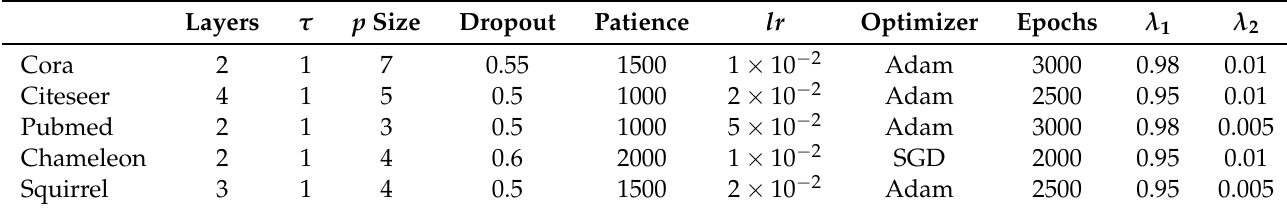
Table A2. Hyper-parameters used for model selection.